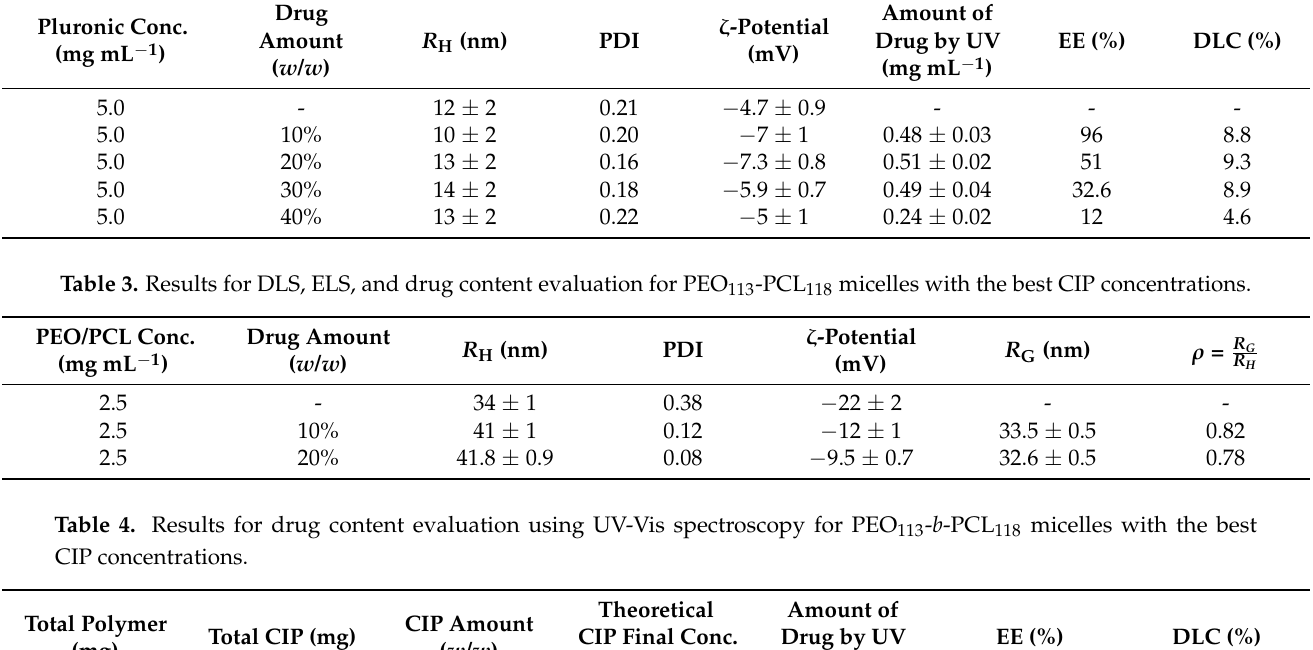
Table 2. Results for drug content evaluation through UV-Vis spectroscopy for different micelle concentrations in water. Pluronic Conc.